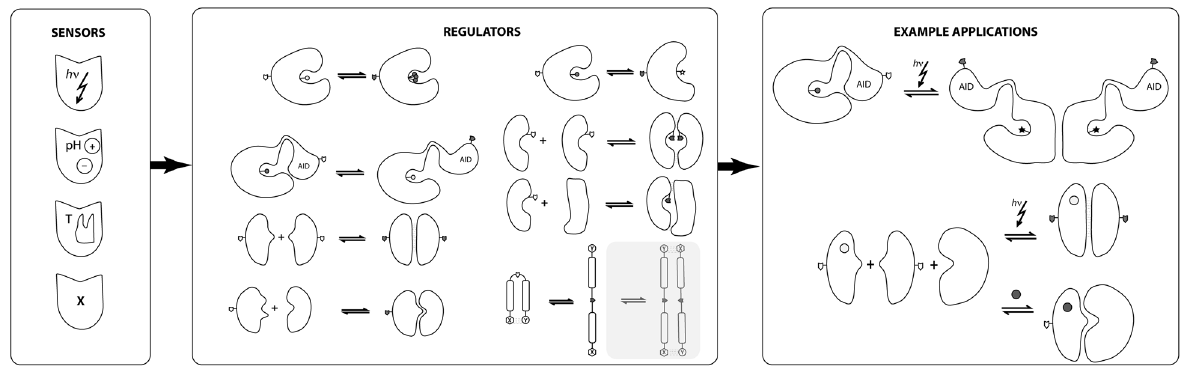
Fig. 4 Bioprogramming in action: A suite of disparate sensors (FMs) can be functionalized to RUs which can respond upon FM stimulations by functional activation/inactivation, hetero/homo-dimerization, conformational switching and many other potential responses. By combining RUs and FMs, we can assemble combinatorial number of possible applications with desired